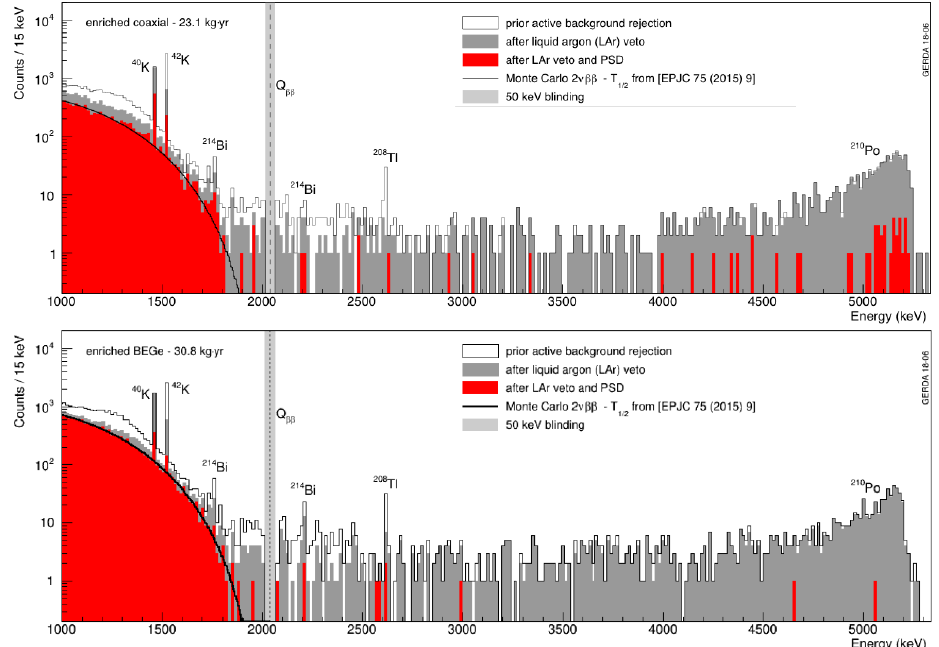
Figure 5. The G ERDA Phase II energy spectra: 23.1 kg · yr for the C OAX ( top ) and 30.8 kg · yr for the BEG E ( bottom ), for a total exposure of 58.93 kg · yr.